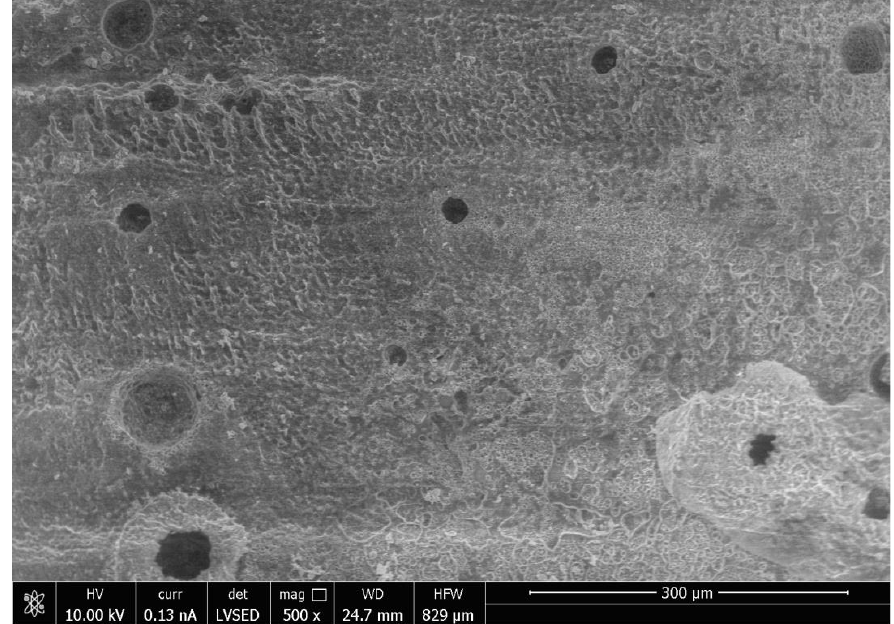
Figure 5. Scanning Electron Microscope Image of the Surface of the Tooth at Magnification 500× Following Crown Removal with Air Rotary Handpiece.